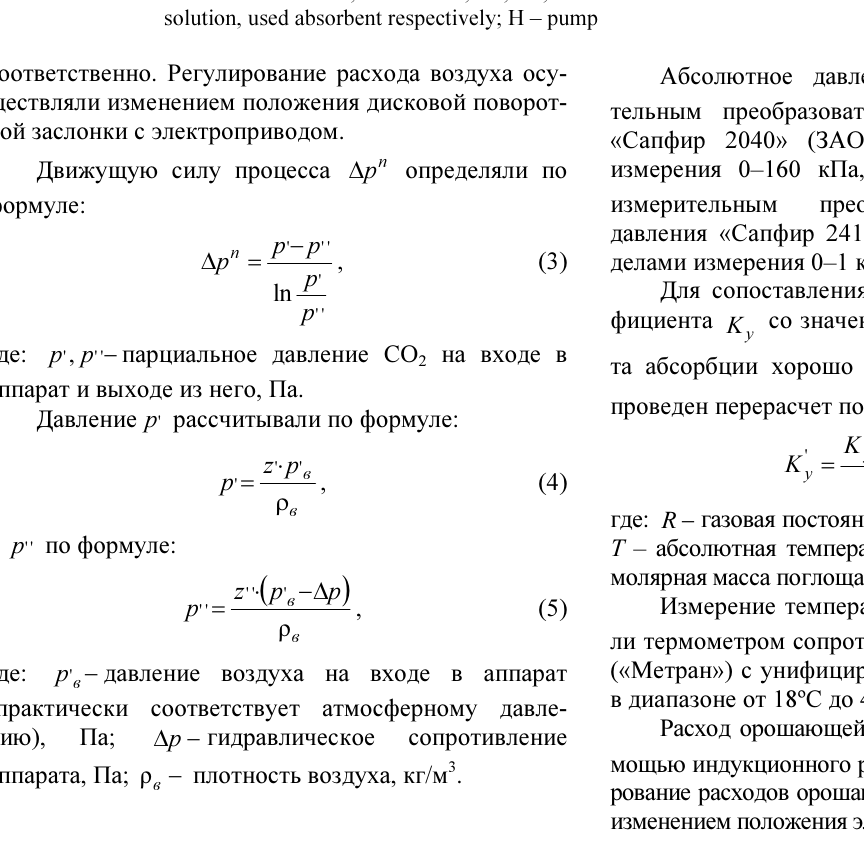
Fig. 3. Scheme of experimental plant: А – absorber with fibrous nozzle; Б – steel balloon with carbon dioxide; В – cooler; Е1, Е2, Е3 – reservoirs with new absorbent, working solution, used absorbent respectively; Н –